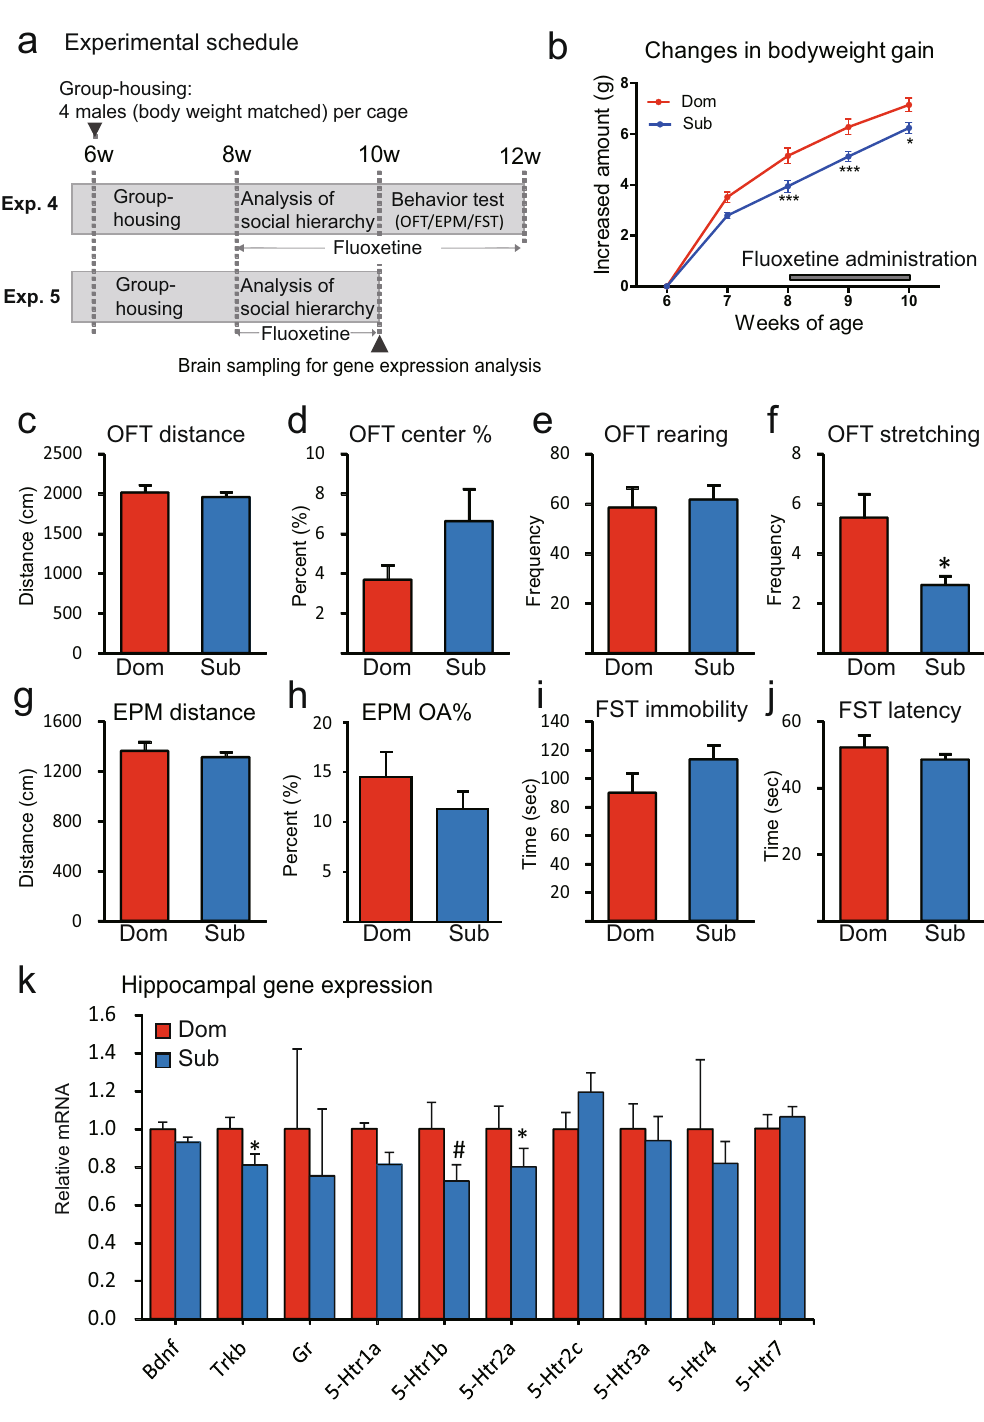
Figure 6. Effects of fluoxetine on behaviour and gene expression. The effects of an antidepressant on anxiety- and depression-like behaviour were assessed by treating group-housed mice with fluoxetine, a selective serotonin reuptake inhibitor, in drinking water. ( a ) Fluoxetine treatment experimental schedule for the behavioural tests and gene expression analysis. In Experiment 4, all animals were used in behavioural tests when they were aged 10–12 weeks ( n = 16 cages). In Experiment 5, brains were collected when the mice were 10 weeks old, and gene expression analysis was performed ( n = 8 cages). ( b ) Comparison of body weight gains in group-housed mice with different hierarchical positions ( * P < 0.05, ** P < 0.01, *** P < 0.001, dominant versus subordinate). ( c – j ) Comparison of behaviours in dominant (Dom) and subordinate (Sub) males. ( c – f ) Results of the open-field tests (OFT), ( g and h ) results of the elevated plus-maze (EPM) tests, and ( i and j ) results of the forced swim tests (FST) ( * P < 0.05). ( k ) Comparison of gene expression levels in the hippocampi of the Dom and Sub males ( # P < 0.1, * P <